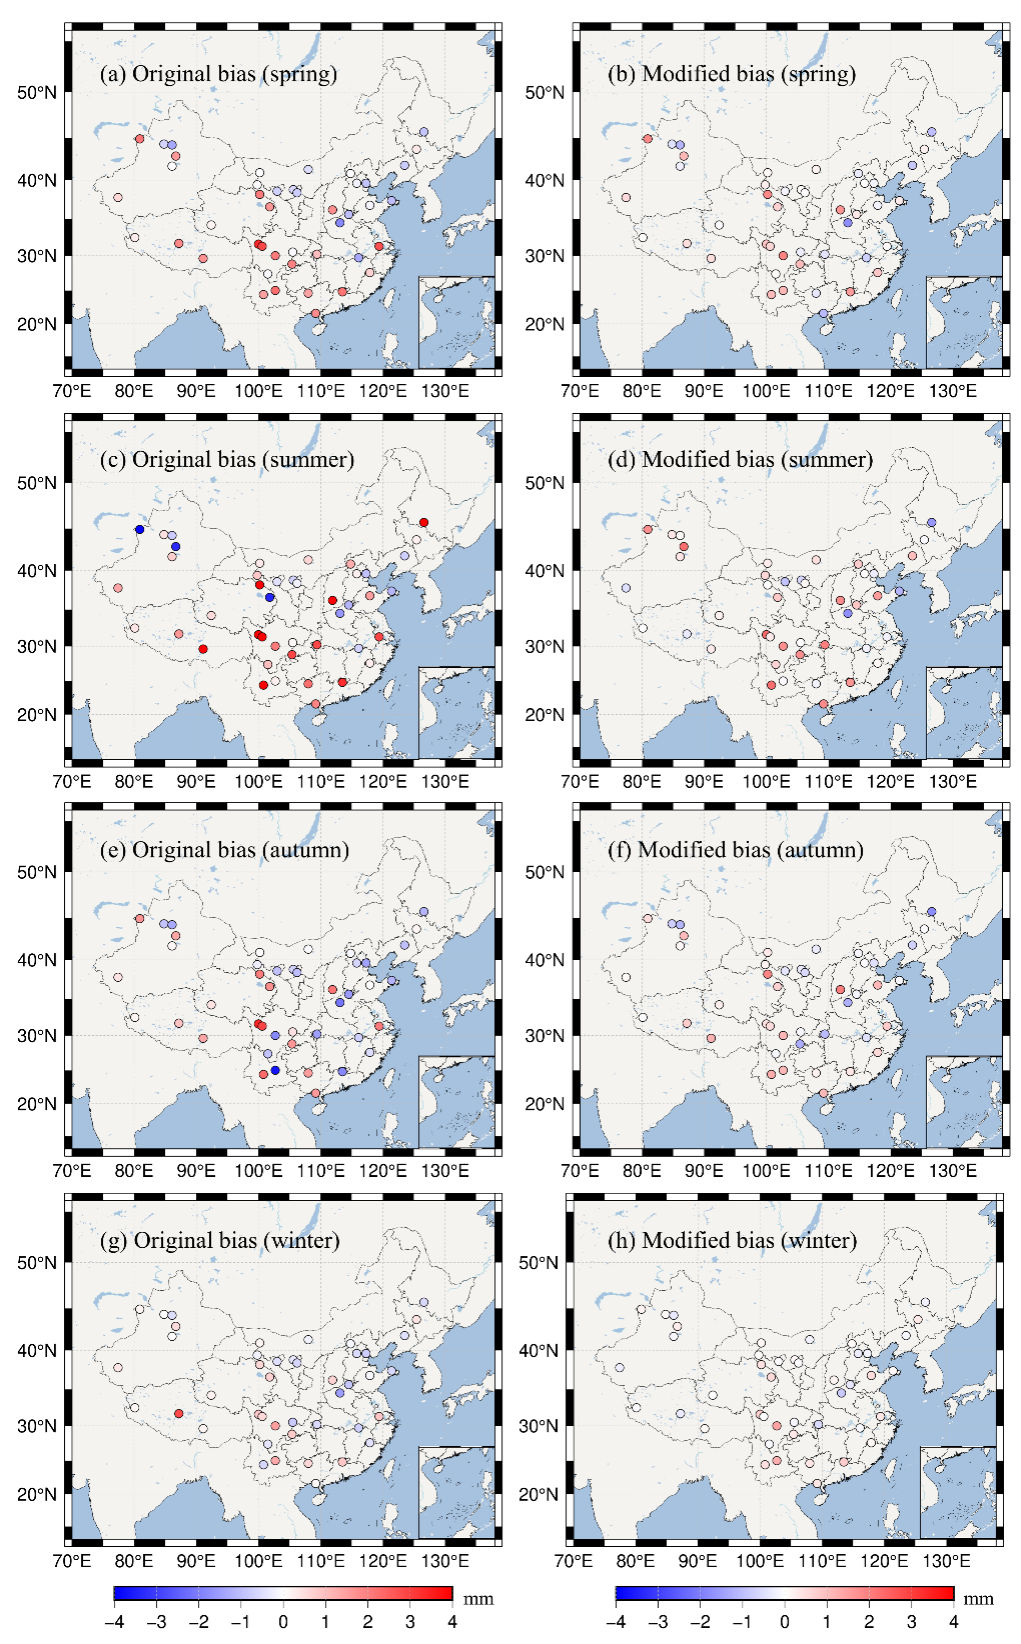
Figure 10. PWV biases at verification stations of the original ERA5 PWV and the modified ERA5 PWV.